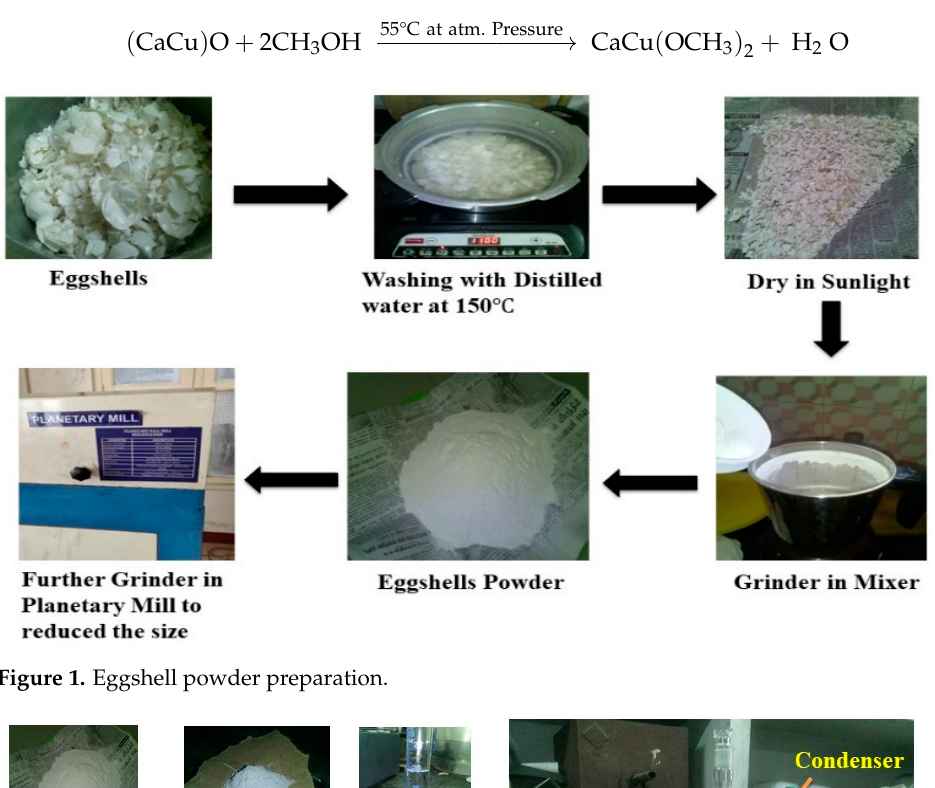
Figure 1. Eggshell powder preparation.